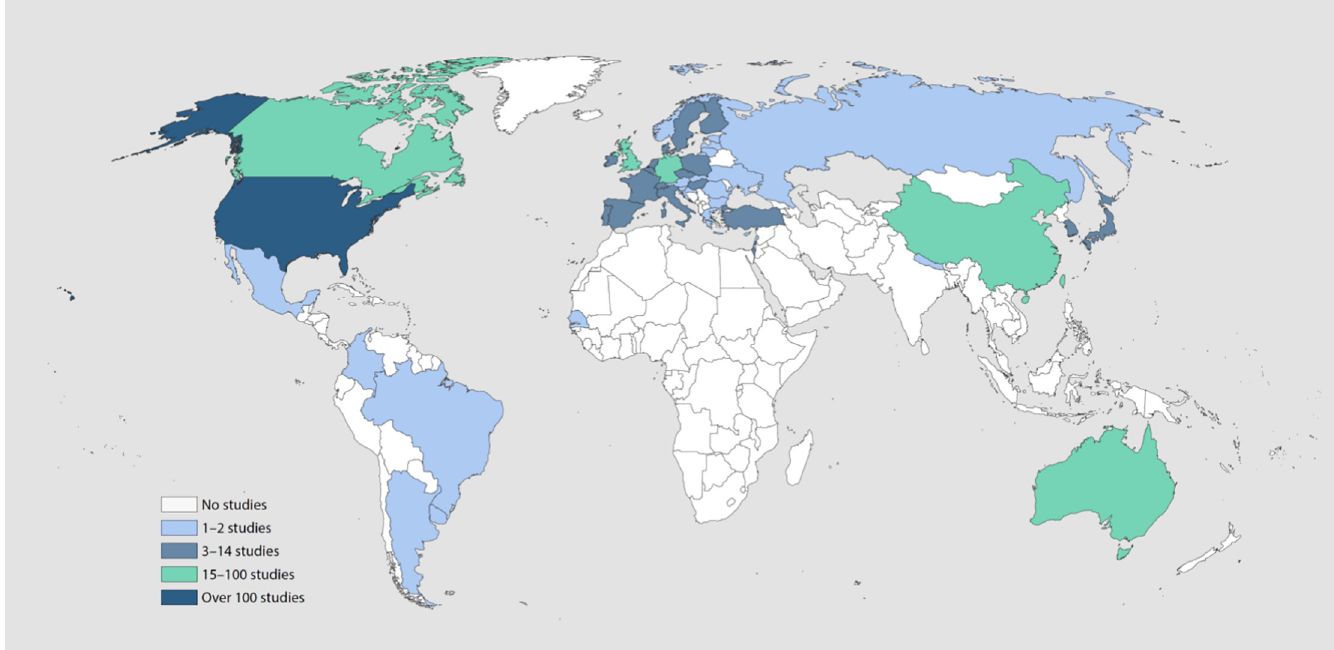
Fig 4. Geographic distribution of ageism studies across 45 countries.